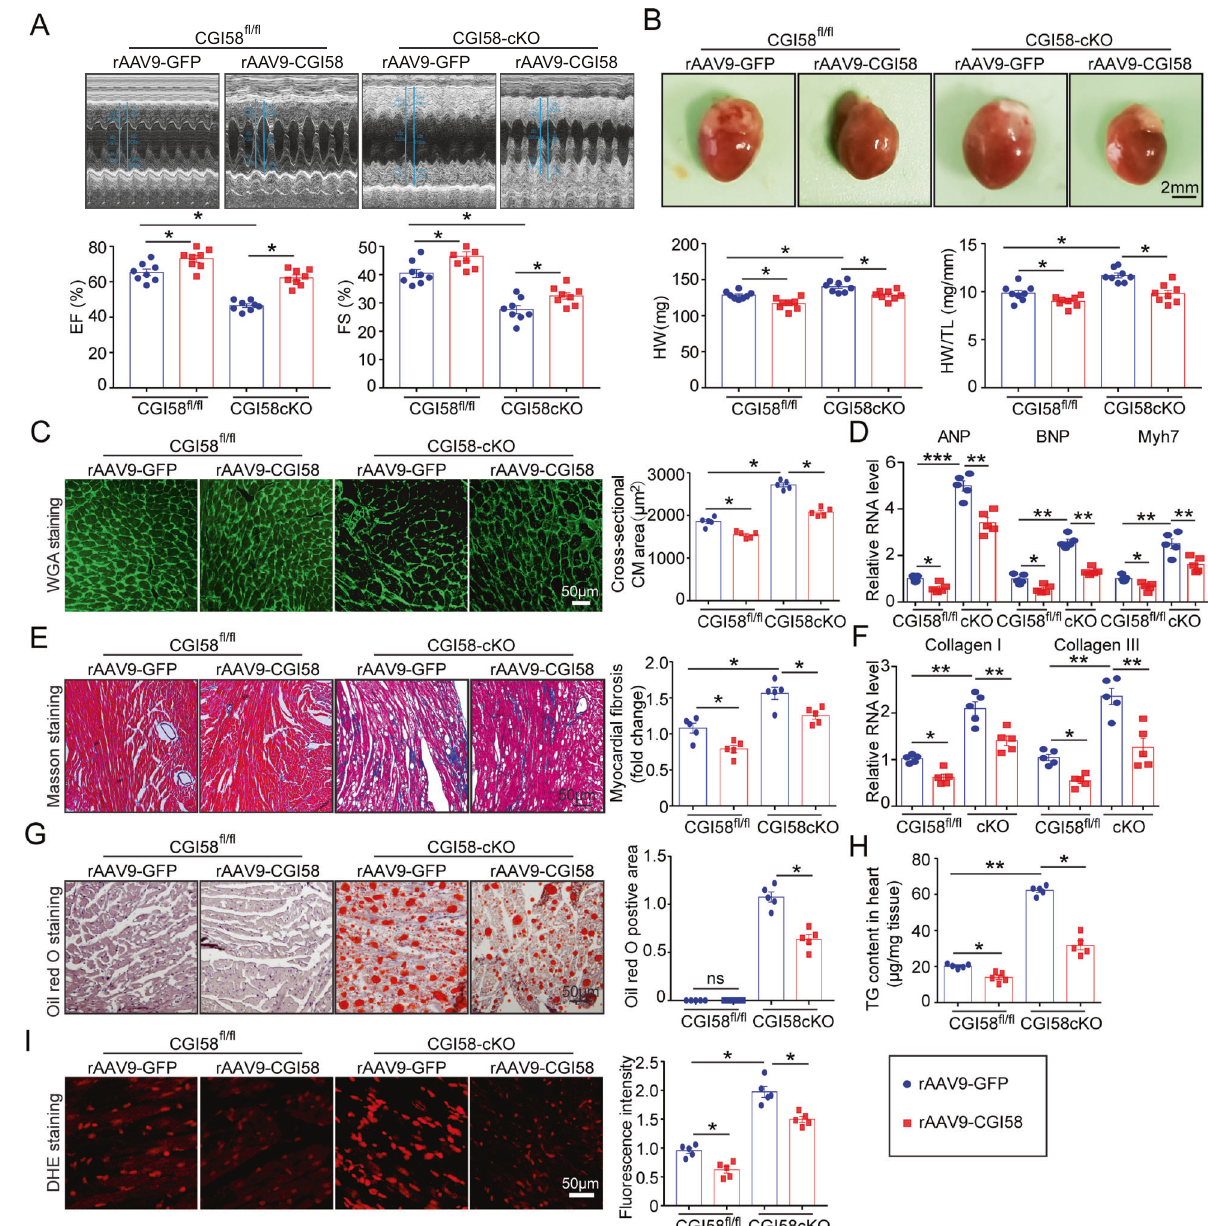
Fig. 3 Re-expression of CGI-58 by rAAV9 injection reverses cardiac remodeling and dysfunction in CGI-58 knockout mice. A M-model echocardiography of the left ventricle (upper). Measurement of EF% and FS% (lower, n = 8). B Heart size (upper), heart weight, and HW/TL ratio (lower, n = 8). Scale bar 2 mm. C FITC-labeled WGA staining of the heart sections (upper). Quanti fi cation of the relative myocyte cross- sectional area (lower, n = 5). D qPCR analyses of ANP , BNP , and Myh7 mRNA levels ( n = 5). E Masson ’ s Trichrome staining of heart sections (left) and the quanti fi cation of fi brotic area (right, n = 5). F qPCR analyses of collagen I and collagen III mRNA levels ( n = 5). G Oil Red O staining of heart sections (left) and the quanti fi cation of lipid accumulation ( n = 5). H Measurement of TG content in the heart ( n = 5). I DHE staining of heart sections (left) and the quanti fi cation of ROS level (right, n = 5). Scale bar 50 μ m. Data are presented as mean ± SEM, and n represents the number of samples or animals. * P < 0.05, ** P < 0.01, *** P <